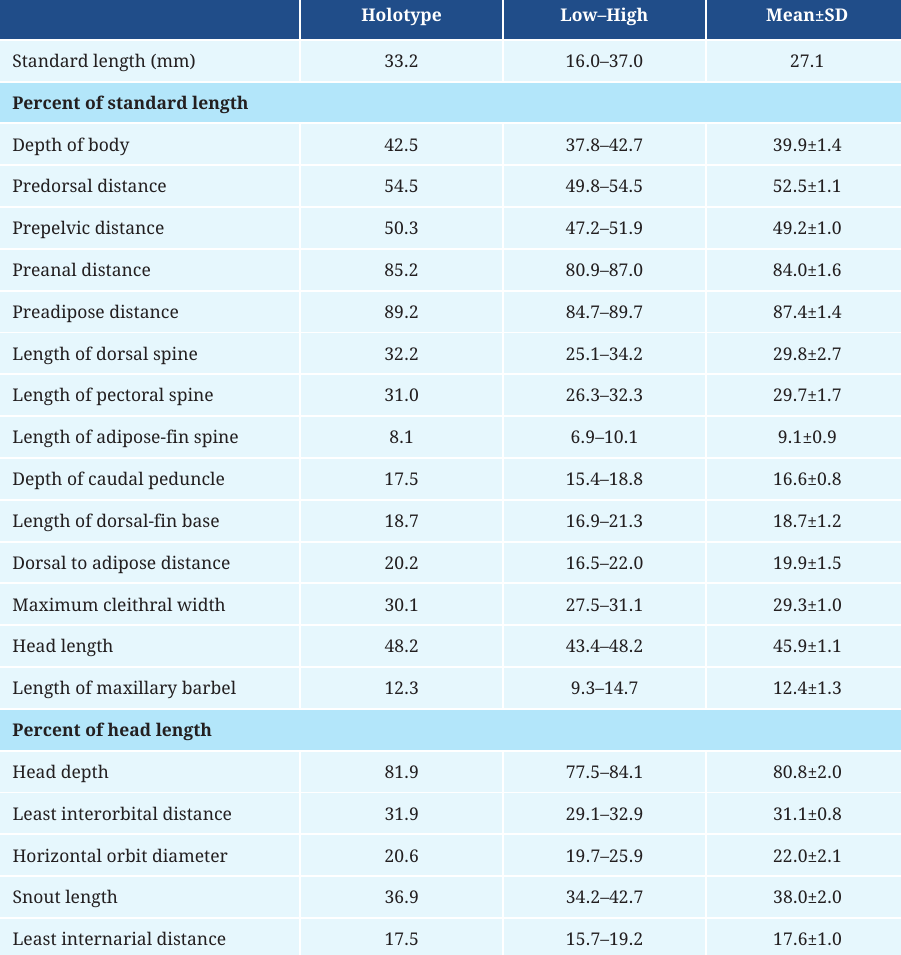
TABLE 1 | Morphometric data of the holotype and 19 paratypes of Corydoras thanatos . SD = Standard